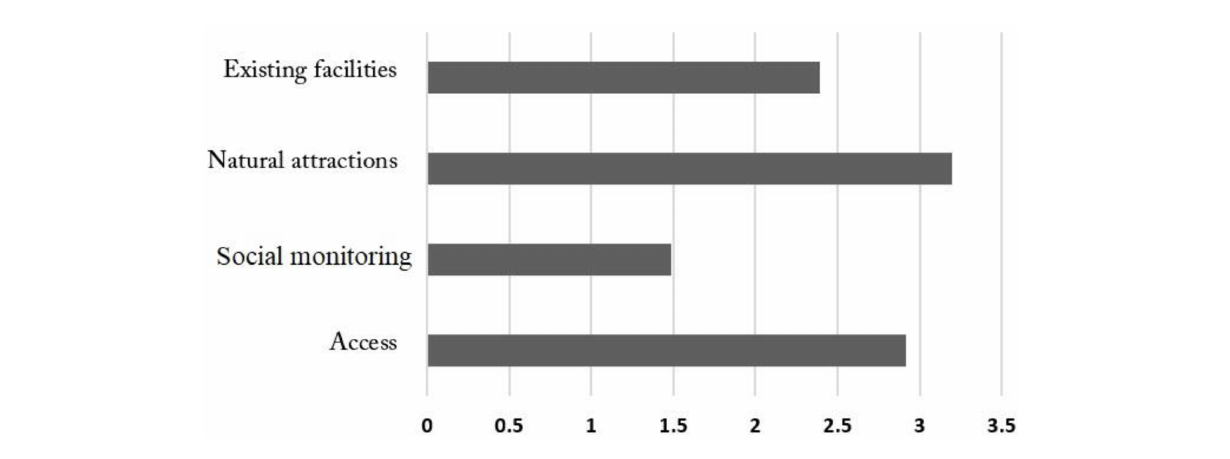
FIGURE4 Ranking of visitors’ expectations of